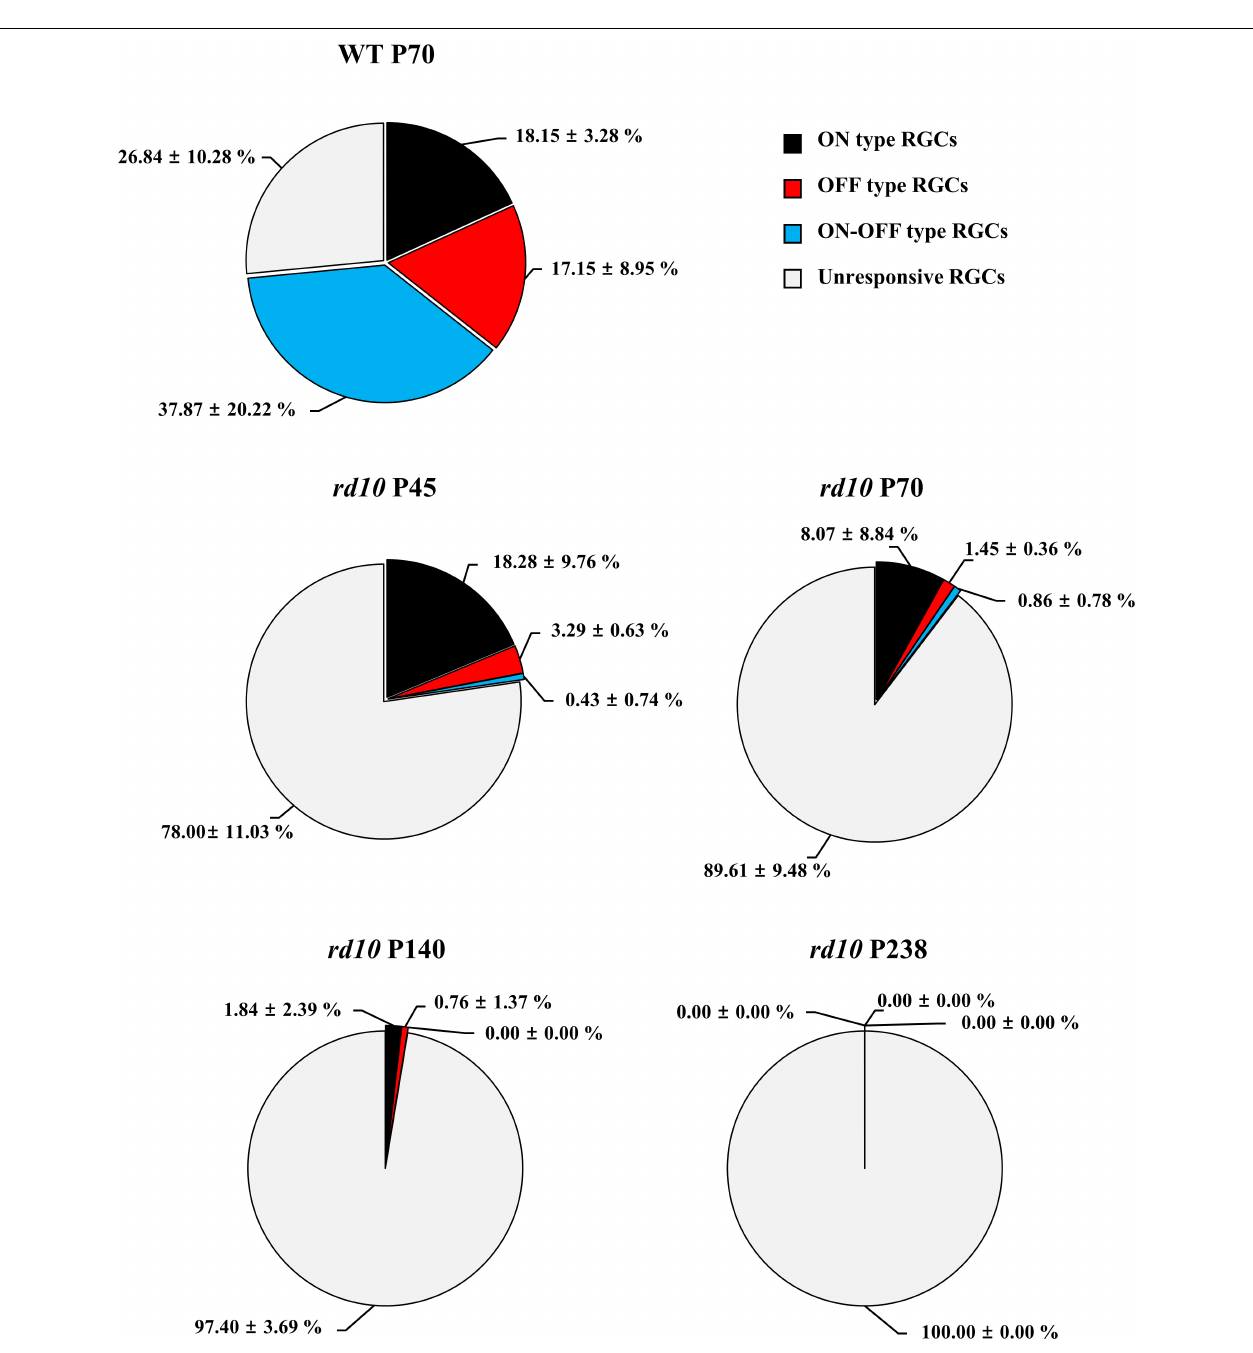
FIGURE 5 | The progressive decrease of retinal ganglion cells (RGCs) that respond to flashed light stimulation in the rd10 mice. The ON type (black), OFF type (red), ON/OFF type (blue), and unresponsive (light gray) RGCs were counted from isolated retinas. The ON and OFF durations of light stimulation were 4 s, respectively.